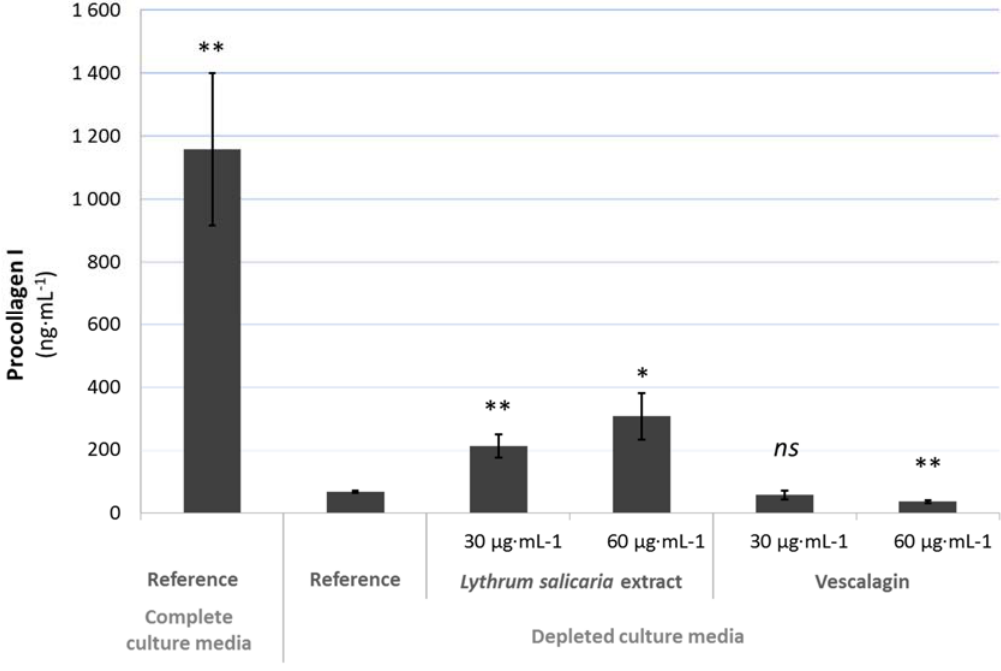
Figure 8. Effect of Lyth. s . extract and vescalagin on expression of procollagen I in FTSK monitored by ELISA quantification in cell culture subnatants of FTSK (statistical significances; see details in Figure 6).